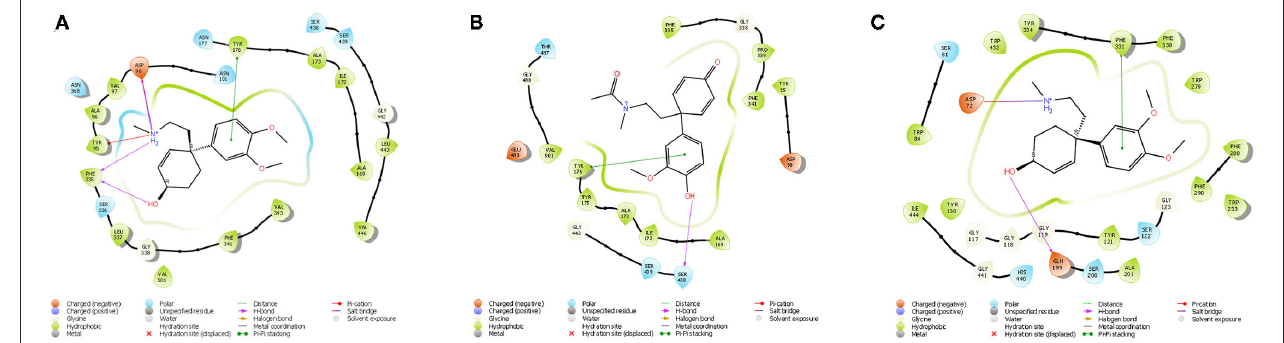
FIGURE 7 | (A) Ligand interaction diagram of Dihydrojoubertiamine (-6.497 1 kcal/mol) in the flumazenil binding site on the GABA-A receptor; (B) Ligand interaction diagram of 4-(3-methoxy-4-hydroxy-phenyl)-4-[2-acetylmethylamino)ethyl]cyclohexadienone (-8.791 1 kcal/mol) in the citalopram binding site on the 5-HT receptor; (C) Ligand interaction diagram of Mesembranol (-9.879 1 kcal/mol) in the galantamine binding site on the AChE